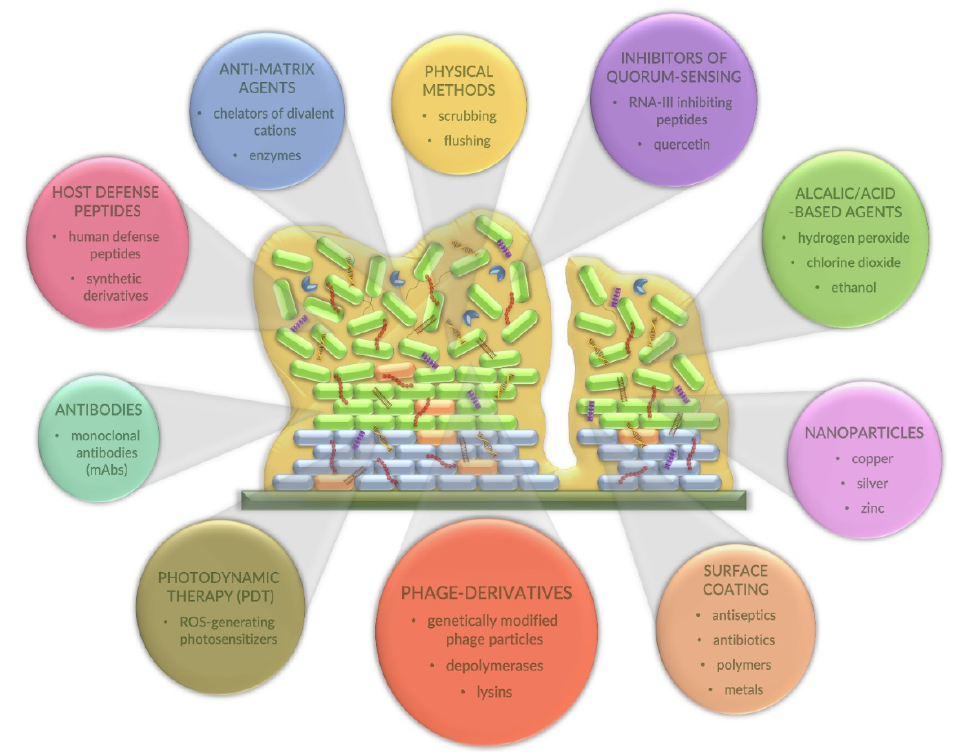
Figure 3. Alternative strategies in the fight against mature biofilm or its formation. Circles show the diverse antibiofilm agents with examples provided. The most common way of treating biofilm infection is the disposal of the contaminated device (e.g., medical equipment implanted) or the removal of formed biofilm [33].